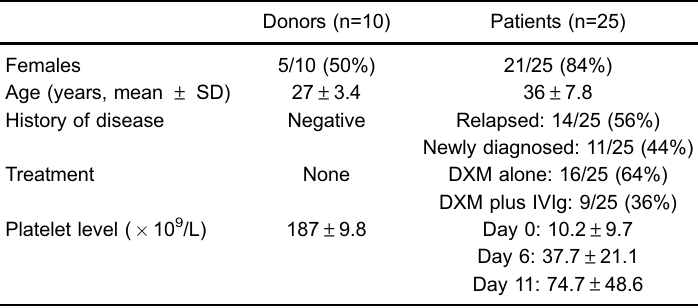
Table 1. Clinical characteristics of healthy donors and immune thrombocytopenia